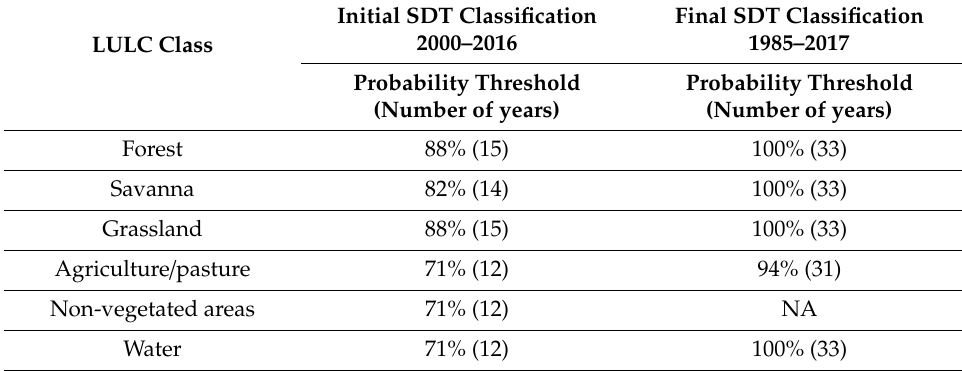
Table 2. Probability thresholds were used to define areas of consistent classification for each land use and land cover (LULC) class. Values inside parentheses indicate the minimum number of years a pixel had to be classified as a given class to be considered consistent, considering a total of 17 years for the initial classification from 2000 to 2016, and 33 years for the final classification from 1985 to 2017. NA = not applicable. SDT, statistical decision